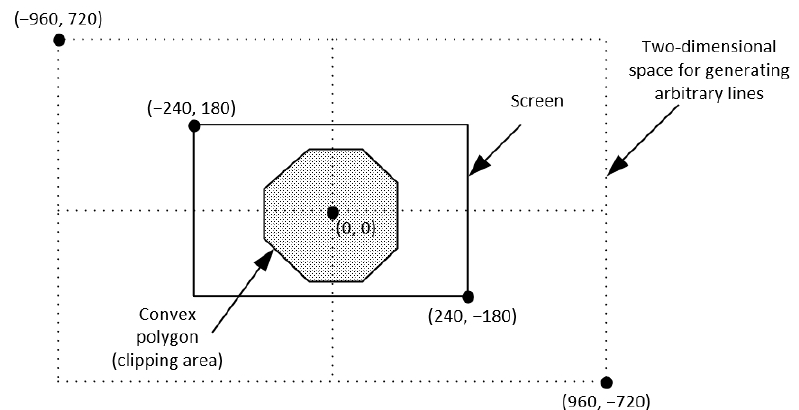
Figure 43. The two-dimensional space for generating arbitrary lines.